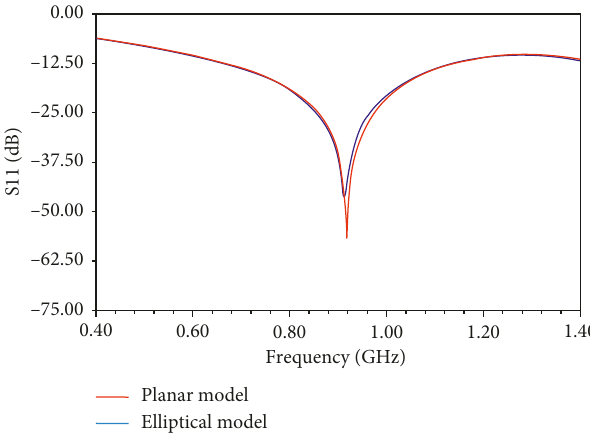
Figure 11: Simulated S 11 of the first proposed tag on the layered elliptical model and planar